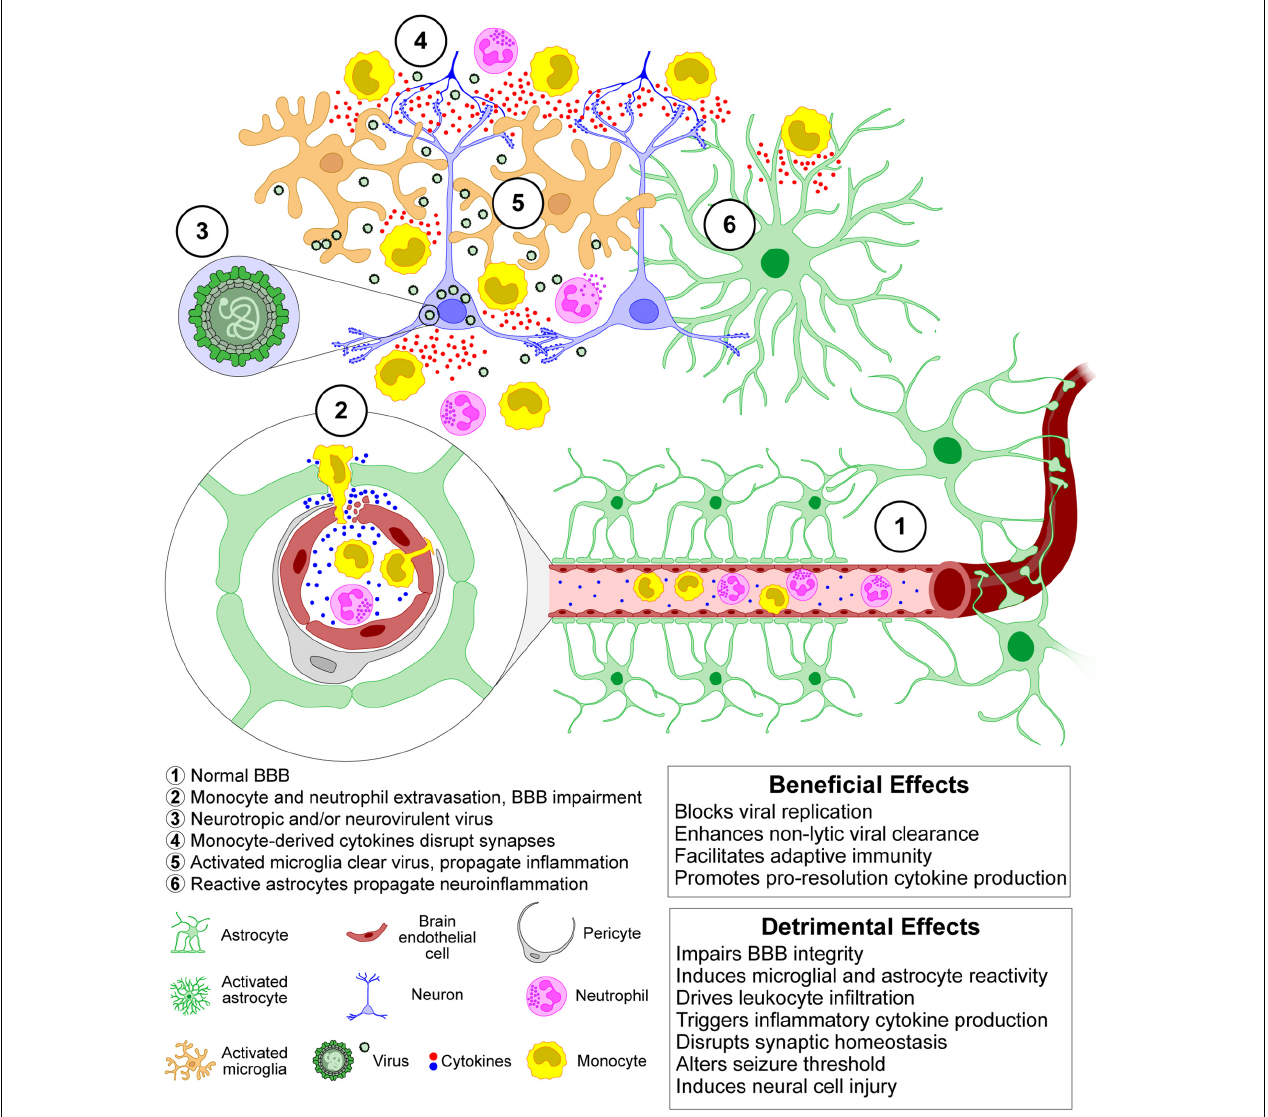
FIGURE 3 | The acute inflammatory and neuroinflammatory responses to CNS viral infection exert both protective and injurious effects. Leukocyte infiltration in response to chemokine production induced by pattern recognition receptor binding to viral components and endogenous alarmins results in potentially pathogenic alterations at the blood-brain barrier and leads to a robust release of cytokines that are critical for enhancing viral control before the development of an adaptive antiviral response. However, these cytokines also disrupt synaptic function and homeostasis, leading to neuronal injury and changes in excitability that confer a pro-ictogenic effect. Ultimately, viral control and clearance from the CNS is a trade-off between exuberant innate immune responses and consequent cellular and circuit